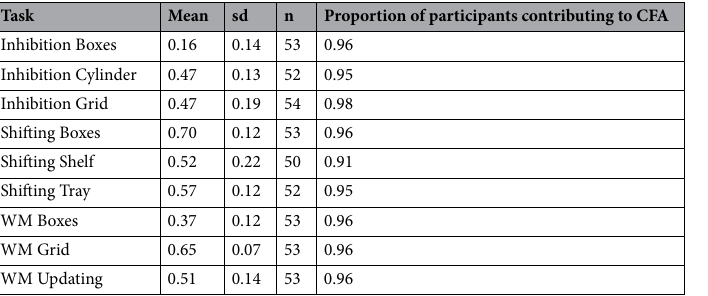
Table 3. Descriptive statistics for the nine executive functions tasks for the entire chimpanzee sample (N = 55).